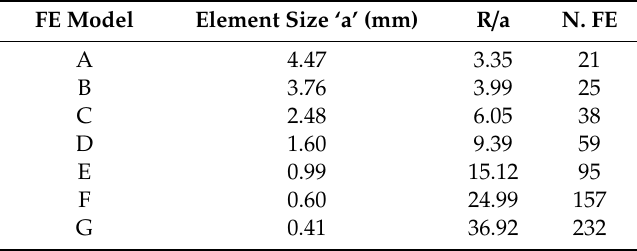
Table 2. FE size of the di ff erent models reported in Figure 6.